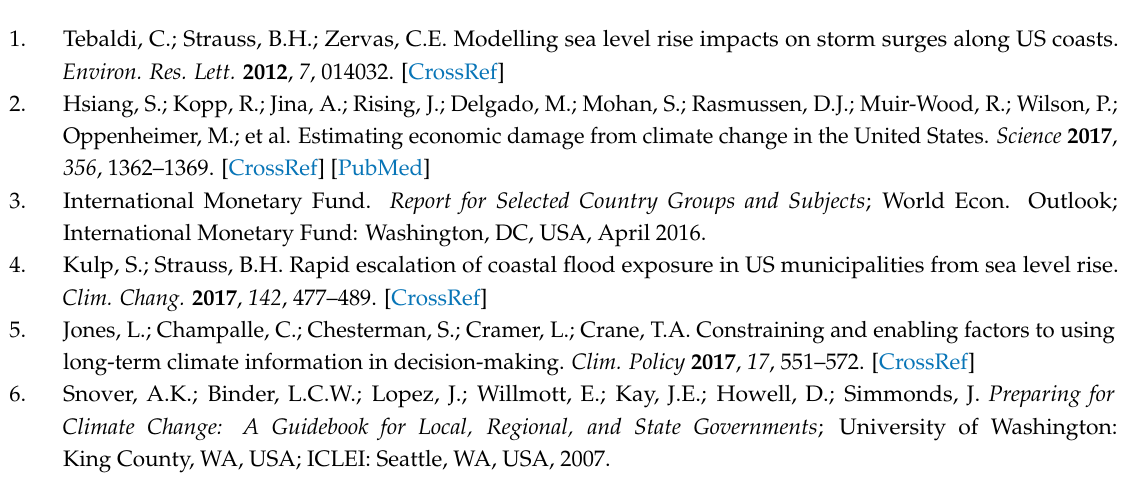
Table S1. Inclusion and exclusion criteria for literature searches in present study; Table S2. Documents included in the analysis; Table S3. Observed and expected frequencies by sub-region and type of database; Table S4. Observed and expected frequencies by region and document